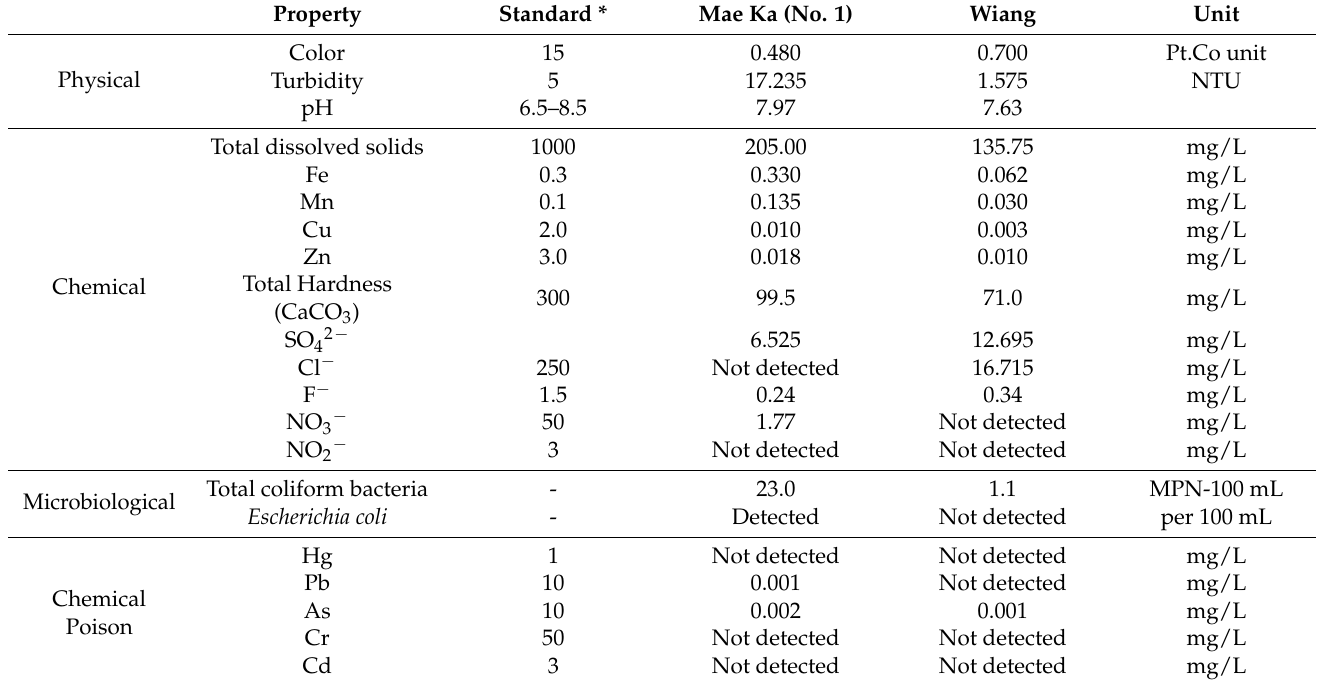
Table 1. The water turbidity, color, pH, and trace element